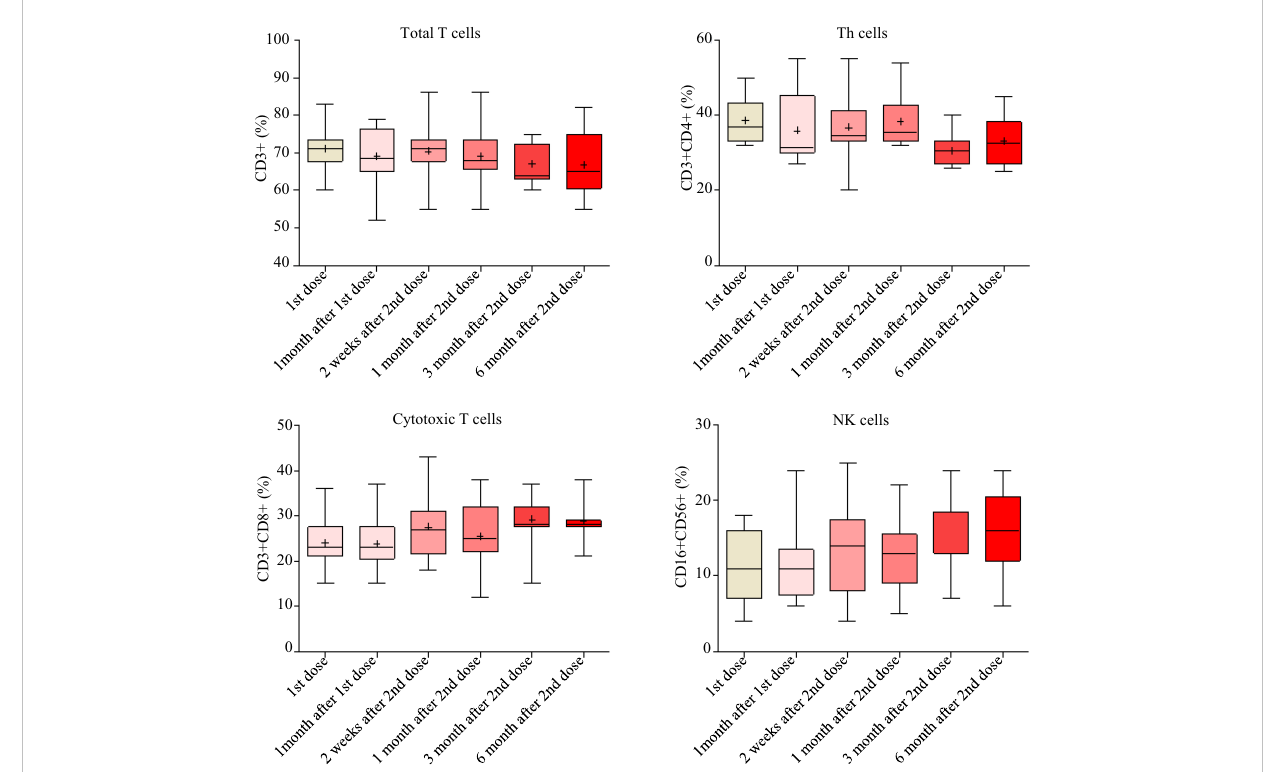
FIGURE 6 T cell responses measured by fl ow cytometry from baseline to 6 months after the second